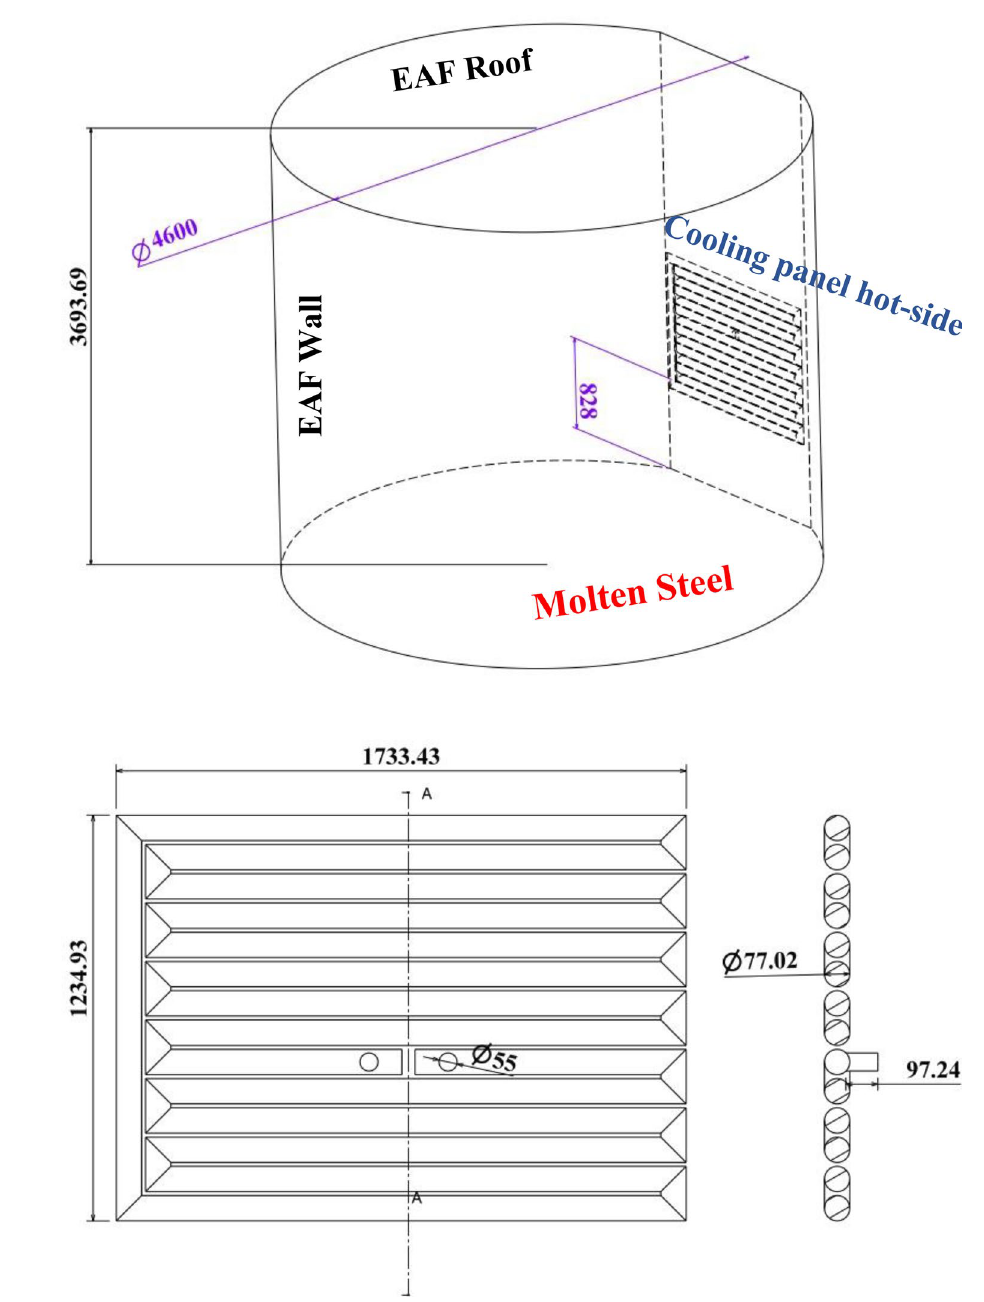
Fig. 2 EAF Geometry and the location of WCP